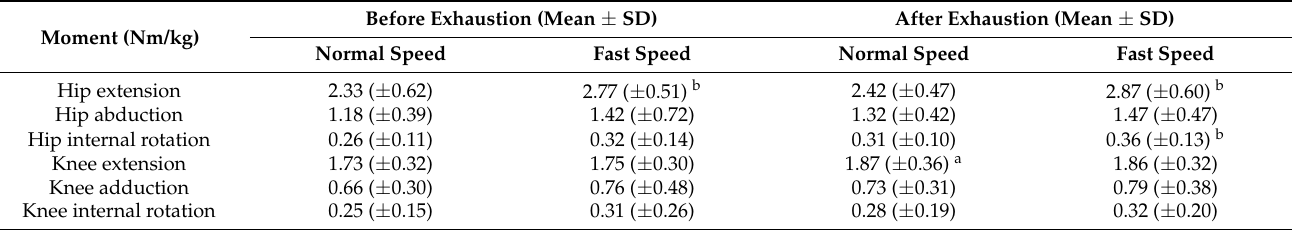
Table 3. Peak joint moments for different speeds for pre- and post-conditions.